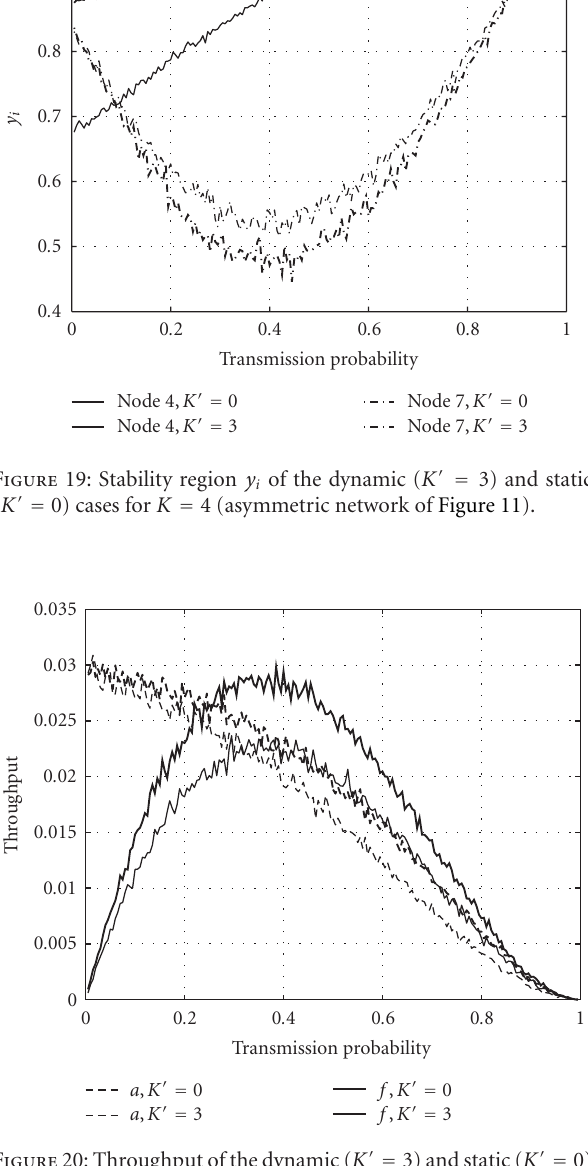
Figure 18: Delay of the dynamic ( K (cid:5) = 2) and static ( K (cid:5) = 0) cases for K = 4 (asymmetric network of Figure 11).